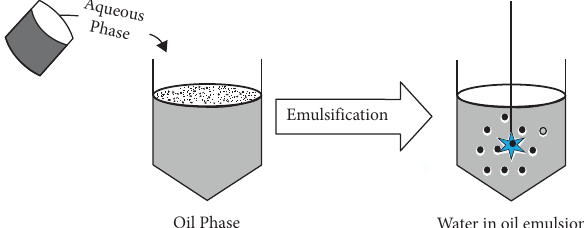
Figure 2: Polymerization of monomers.